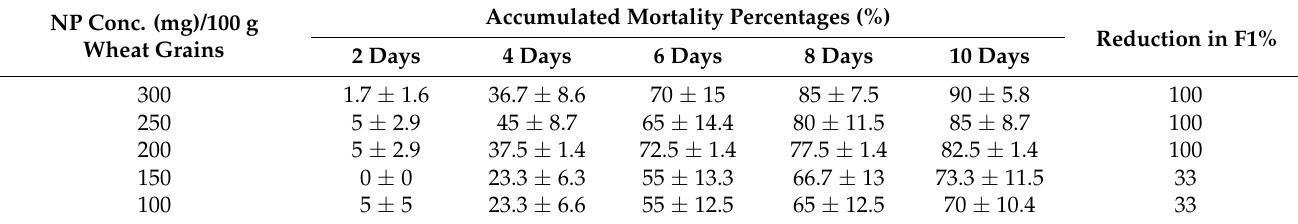
Table 2. The efficacy of CuO-NPs synthesized using A. niger G3-1 against R. dominica insect. Accumulated Mortality Percentages NP Conc. (mg)/100 g Wheat Grains